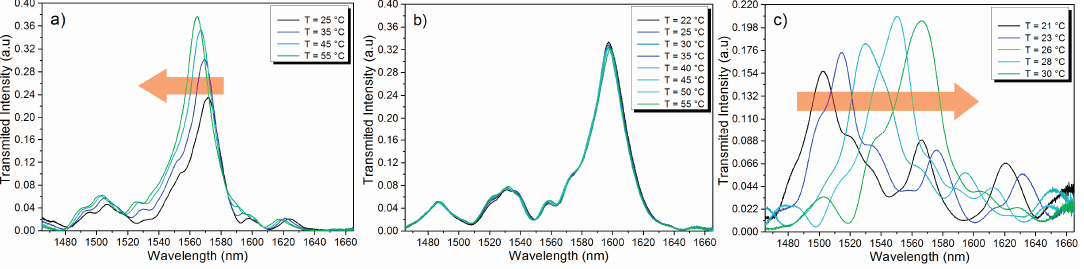
Figure 4. Experimental LC-MMI spectral response for ( a ) n c0 = 1.552, ( b ) n c0 = 1.510, and ( c ) n c0 = 1.464 at different